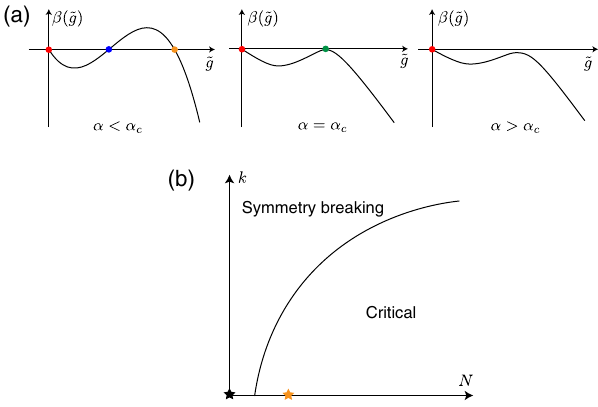
FIG. 3. Fixed point structure and schematic phase diagram of SL ð N;k Þ . In (a), different fixed point structures for different values of α are shown. There is always an attractive fixed point, represented by the red circle, which corresponds to the sym- metry-broken state. The structure of the other fixed points ∼ O ð 1 Þ . The precise depends on the relation between α and α c value of α depends on β 0 and C . If α < α , there are two other c c fixed points, a repulsive one represented by the blue circle, corresponding to an order-disorder transition, and an attractive one, represented by the yellow circle, corresponding to a stable critical quantum liquid, i.e., the SL. As α increases and ap- proaches α , the blue and yellow fixed points approach each other c and collide when α ¼ α . When α > α , the original blue and c c yellow fixed points disappear (become complex fixed points [25,86]). We would like to take α below α . In (b), a schematic c phase diagram of SL ð N;k Þ is shown. For the ð N; k Þ in the critical regime, it is possible to tune the parameters of the system to yield a critical quantum liquid, while in the symmetry-breaking regime this is not possible. The yellow star represents ð N; k Þ ¼ ð 6 ; 1 Þ , i.e., the U ð 1 Þ DSL, and the black star represents ð N; k Þ ¼ ð 5 ; 1 Þ , the DQCP. The precise boundary between the critical and symmetry-breaking regimes is currently